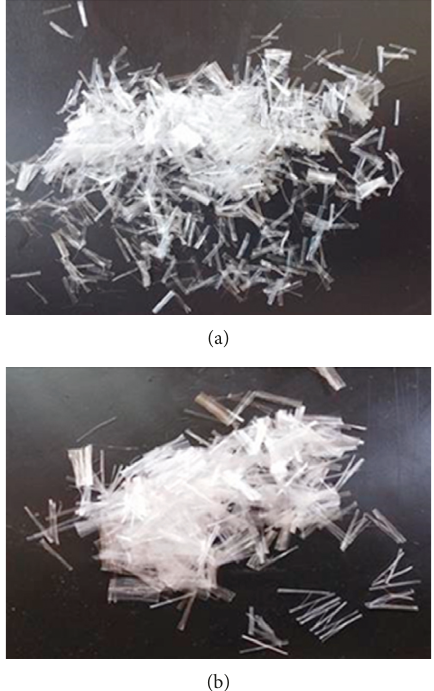
Figure 2: Materials used in this study. (a) 6 mm PP fibers. (b) 12 mm PP fibers.